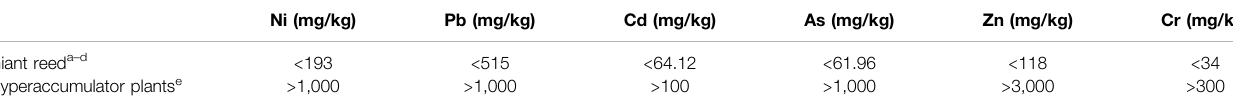
TABLE 2 | Giant reed and hyperaccumulator plants differ in accumulating heavy metal.